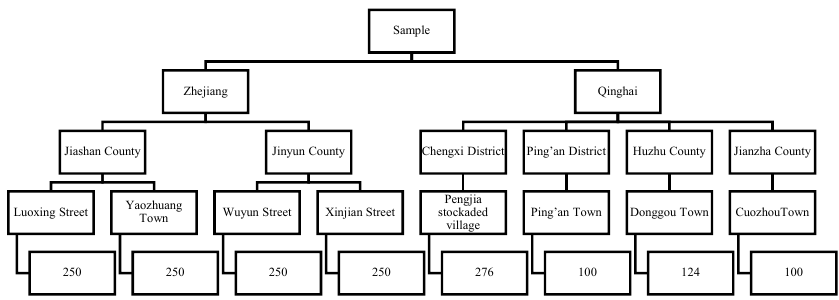
Figure 1. Sampling and sample size.